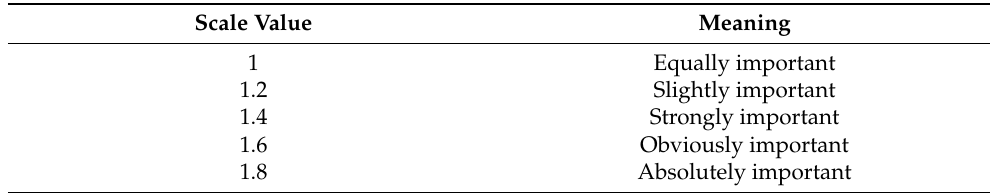
Table 1. Meaning of scale